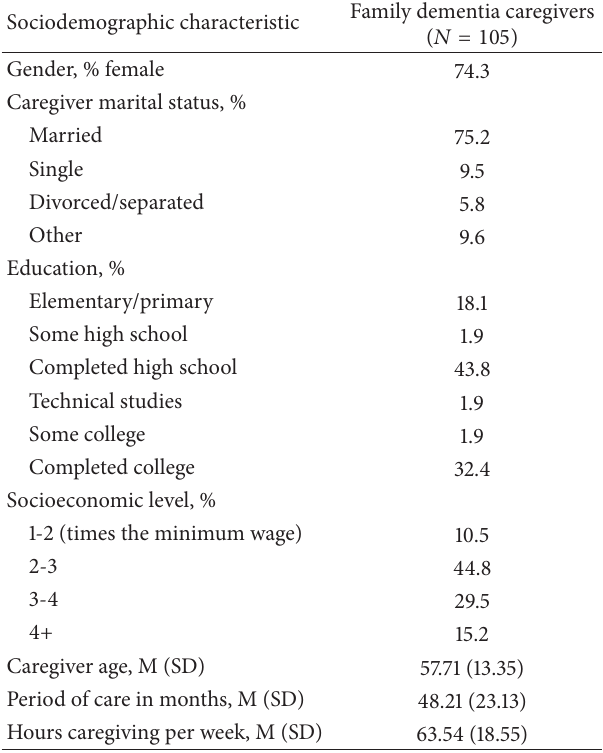
Table 1: Caregiver sociodemographic